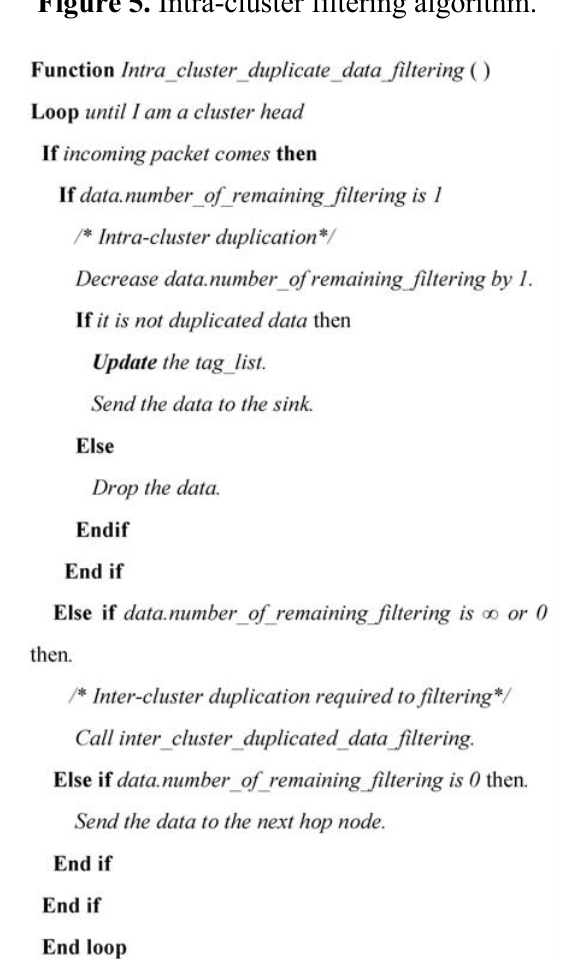
Figure 5. Intra-cluster filtering